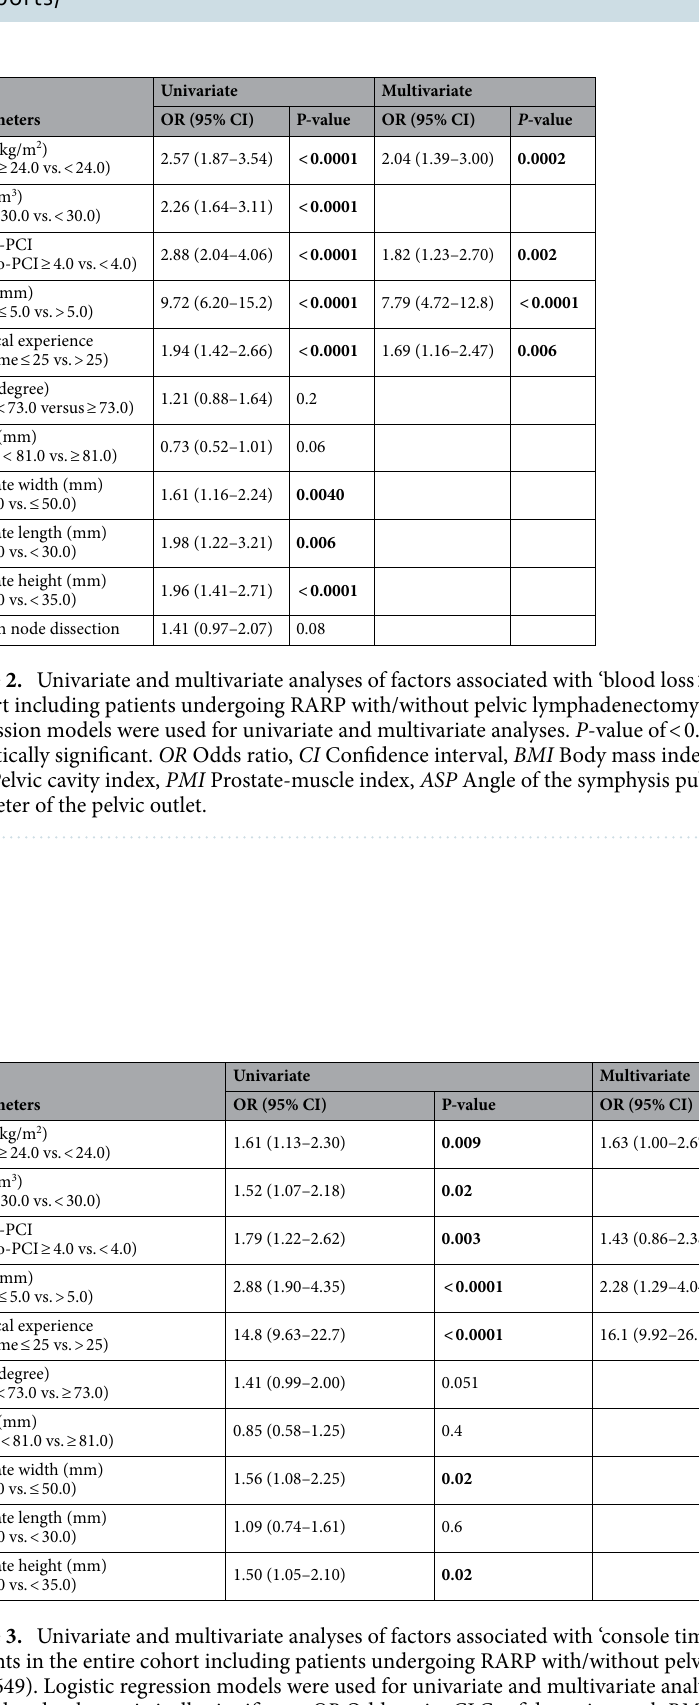
Table 3. Univariate and multivariate analyses of factors associated with ‘console time > 160 min’ in PC patients in the entire cohort including patients undergoing RARP with/without pelvic lymphadenectomy (N = 649). Logistic regression models were used for univariate and multivariate analyses. P -value of < 0.05 was considered to be statistically significant. OR Odds ratio, CI Confidence interval, BMI Body mass index, PV Prostate volume, PCI Pelvic cavity index, PMI Prostate-muscle index, ASP Angle of the symphysis pubis, APO Anteroposterior diameter of the pelvic outlet.